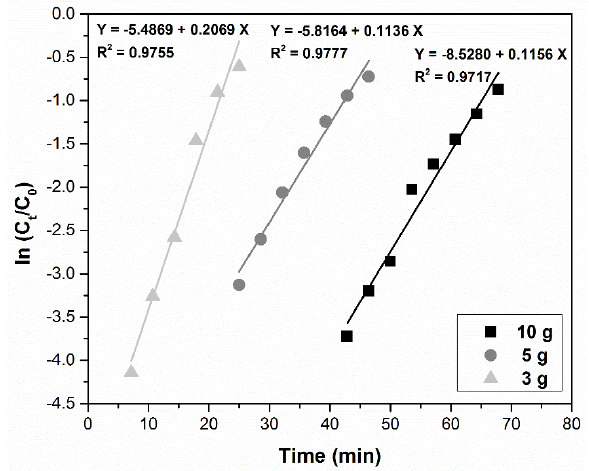
Figure 9. Bohart–Adams model for the adsorption of Pd(II) in a fixed-bed column at various MgSiO 3 -cys amounts.